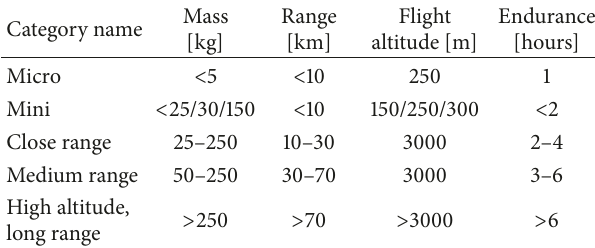
Table 1: Extract of UAV categories defined by UVS International (Unmanned Vehicle Systems Association). Figures on category name “mini” depend on different countries.